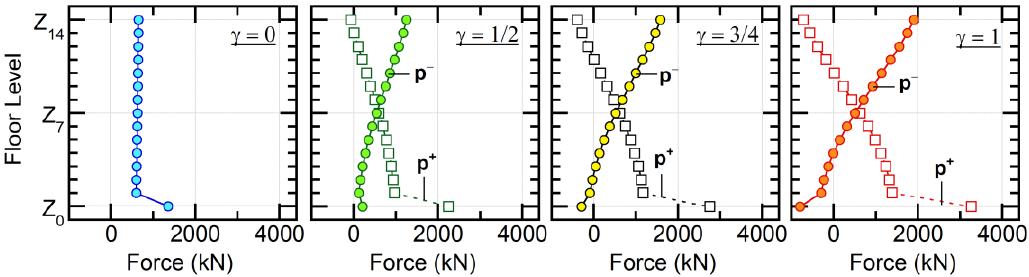
Figure 16. Examples of calculated horizontal-force distributions for Model-14 (Art-S, 100%).